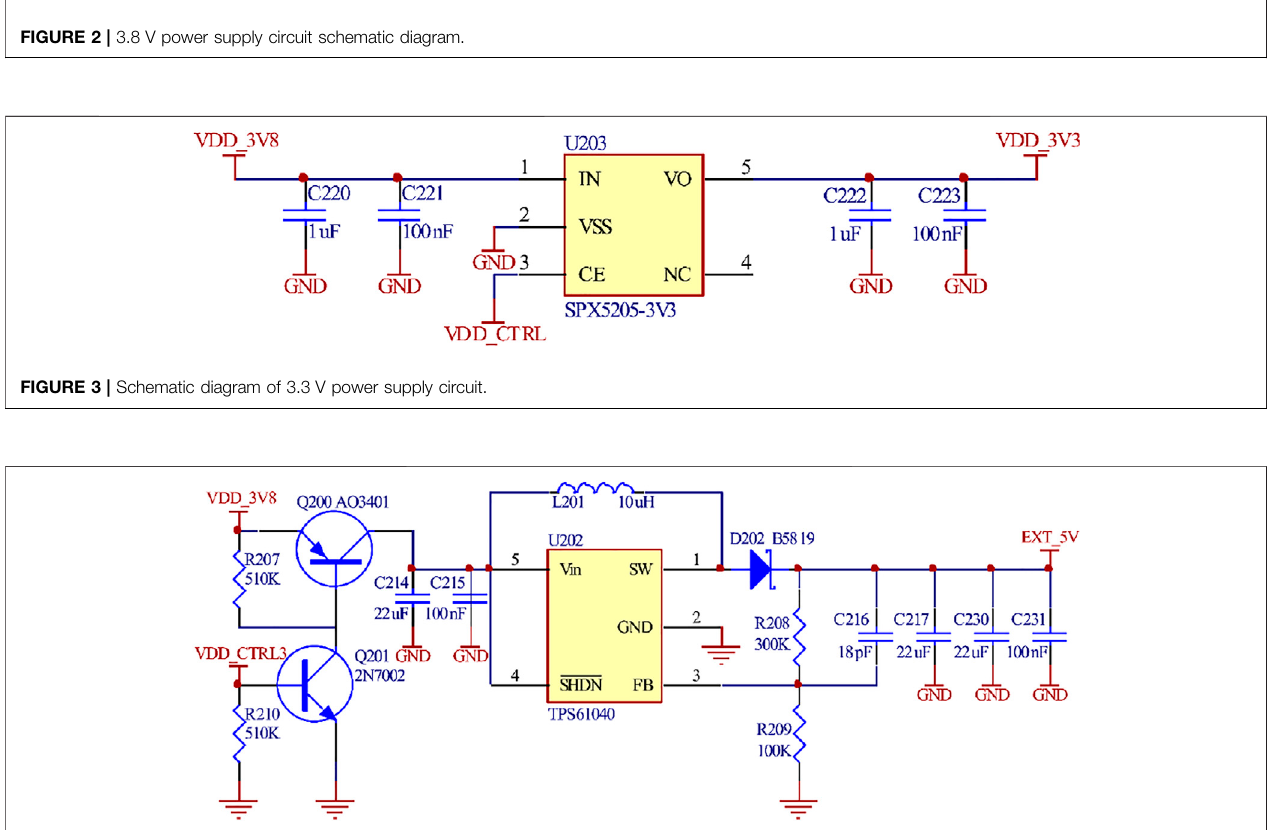
FIGURE 4 | Schematic diagram of 5 V power supply